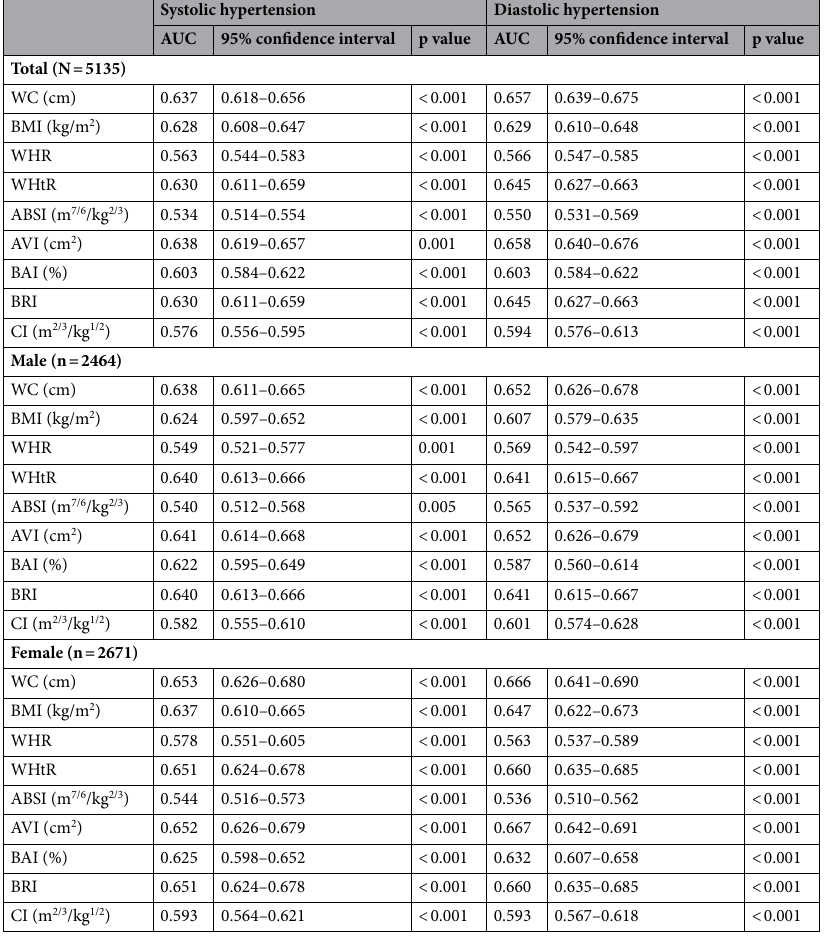
Table 4. AUCs of anthropometric indices for diagnosing hypertension. AUC area under curve, WC waist circumference, BMI body mass index, WHR waist-to-hip ratio, WHtR waist to height ratio, ABSI a body shape index, AVI abdominal volume index, BAI body adiposity index, BRI body roundness index, CI conicity